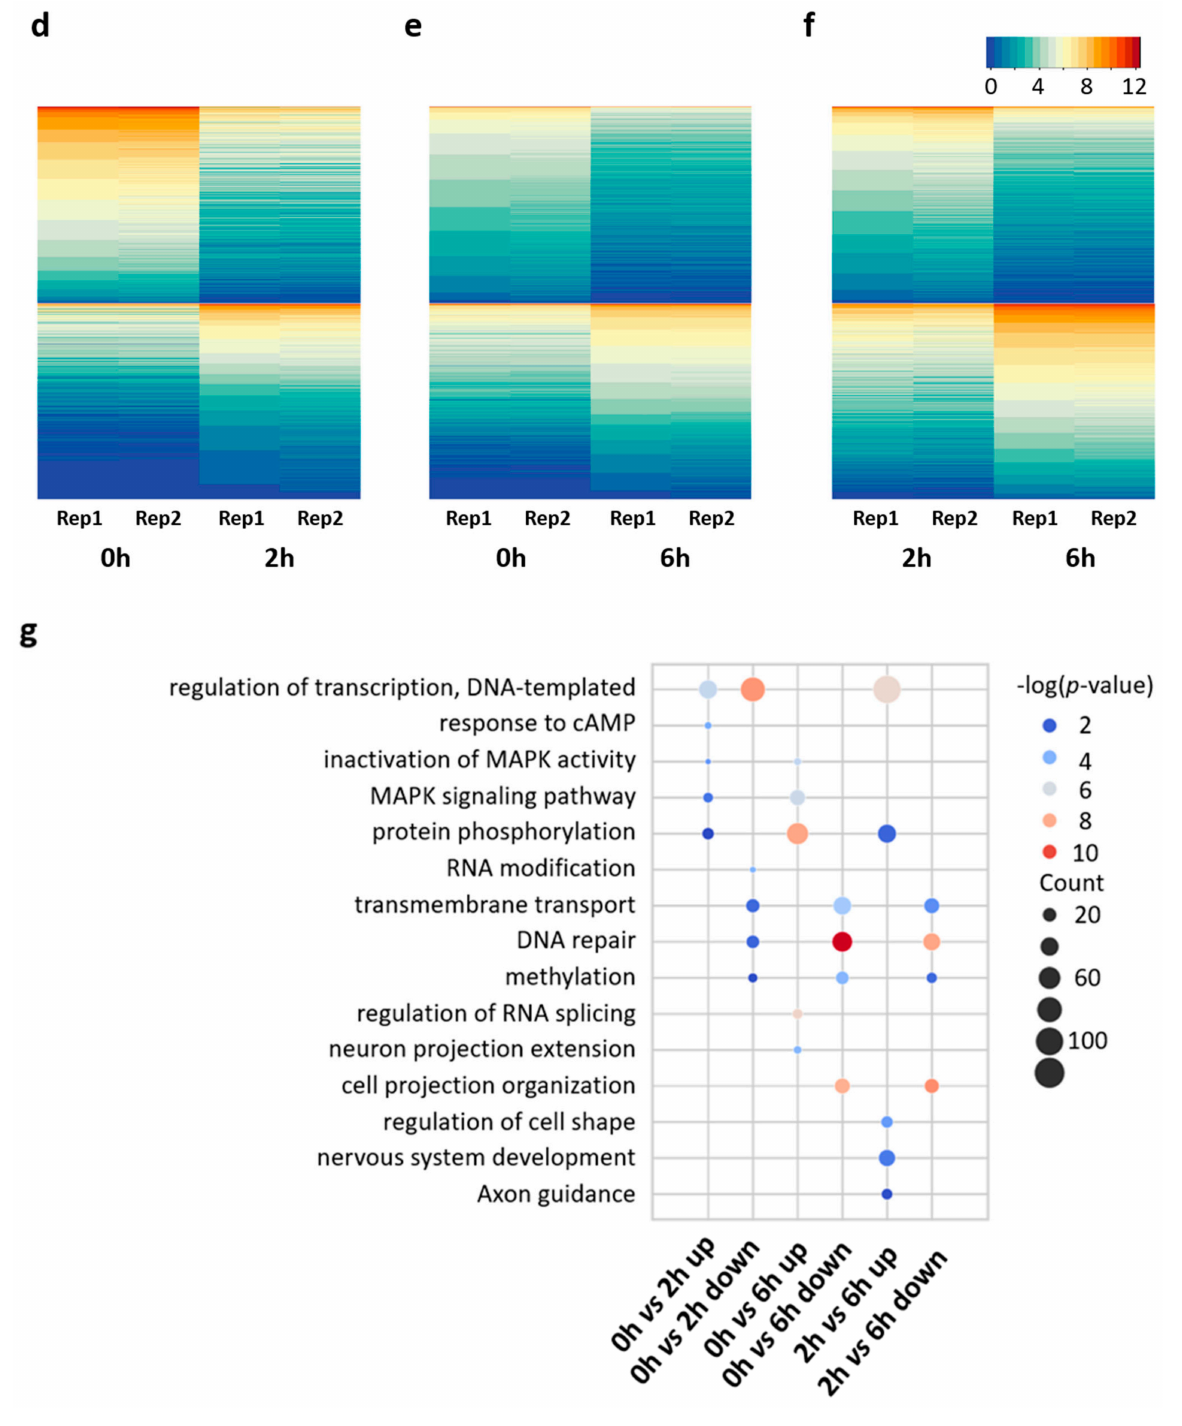
Figure 2. Neuronal depolarization induced dynamic gene expression. ( a – c ) Volcano plot showing the differentially expressed genes (DEGs) (fold change > 2 and adjusted p -value ≤ 0.05) in the comparison of 0 h vs. 2 h ( a ), 0 h vs. 6 h ( b ), and 2 h vs. 6 h ( c ). ( d – f ) Heatmap showing the gene expression level of down-regulated and up-regulated DEGs in the comparison of 0 h vs. 2 h ( d ), 0 h vs. 6 h ( e ), and 2 h vs. 6 h ( f ). ( g ) bubble plot showing significantly enriched GO terms of